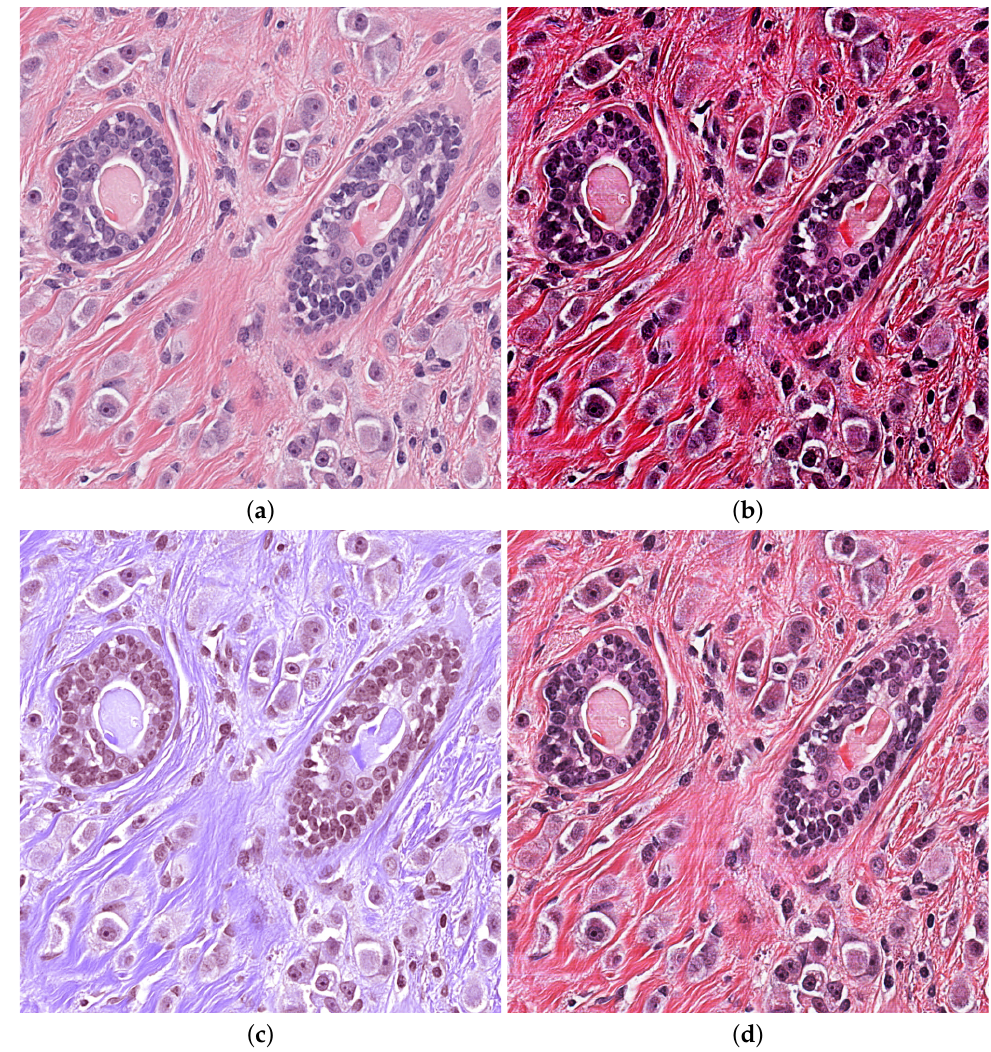
Figure 4. Pre-processing H&E images ( a ) Original image ( b ) CLAHE ( c ) Vahadane ( d )